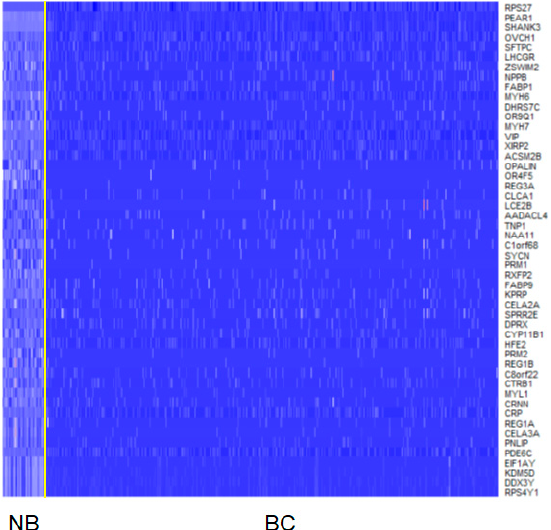
Figure 2. Heatmap of top 50 downregulated genes. The heatmap is drawn with ranks of gene expressions. The yellow line discriminates samples from normal breast and breast cancer. NB, normal breast; BC, breast cancer.